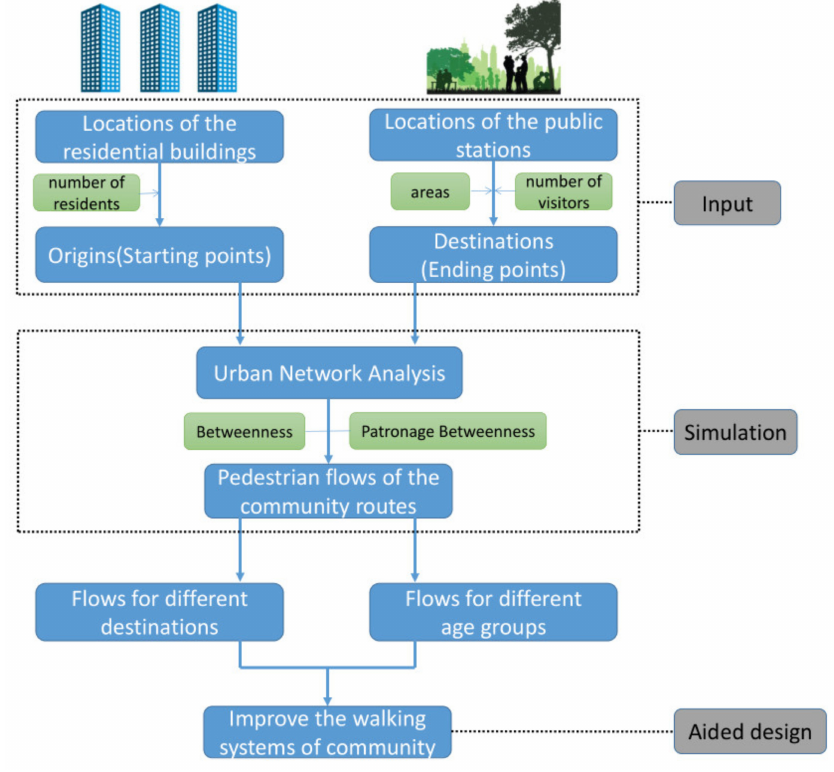
Figure 2. The flow chart of the